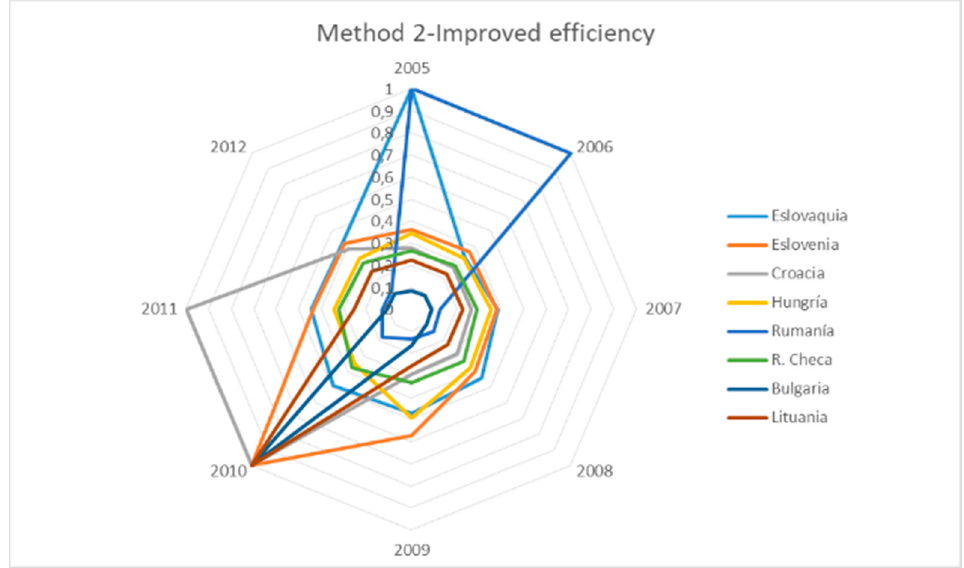
Figure 9. Variation in environmental efficiency in the years 2005–2012 with the DEA Method 1 and for Method 2 for the 14 countries in the category “Improved environmental efficiency”. Source: self